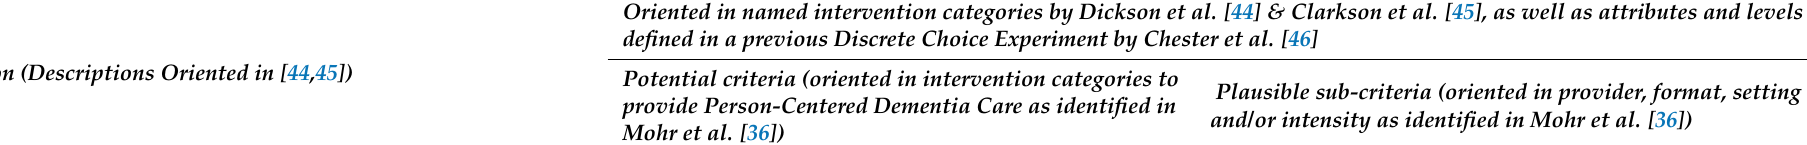
Table 1. Conceptual criteria and potential sub-criteria oriented in systematic literature review